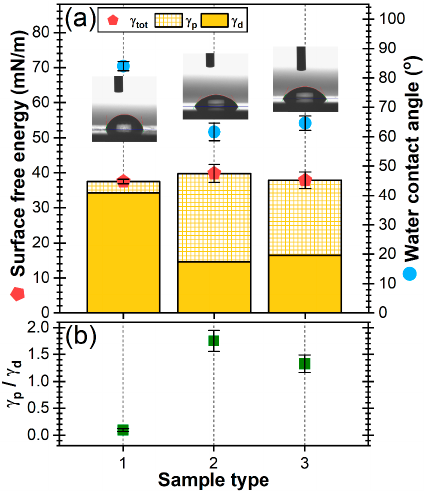
Figure 5. Evolution of the ( a ) surface free energy values ( γ tot ), its polar ( γ p ) and dispersive ( γ d ) components, water contact angle average values and ( b ) ratios of the polar ( γ p )/dispersive ( γ d ) components of the surface free energy, for the (1) bare Ti and (2) FastOs ® BG-derived and (3) Cu&Ga-FastOs ® BG-derived RF-MS coatings.